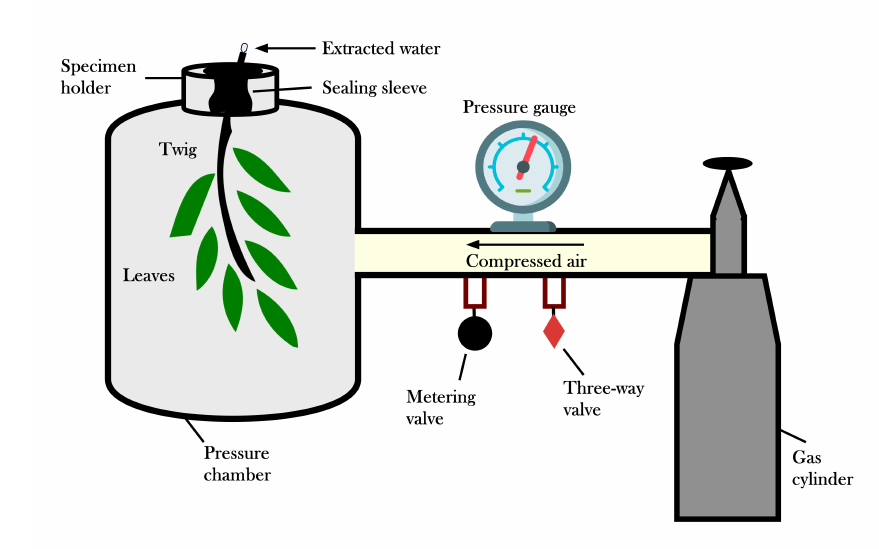
Figure 2. Sketch showing the technical setup of the Scholander-type pressure chamber